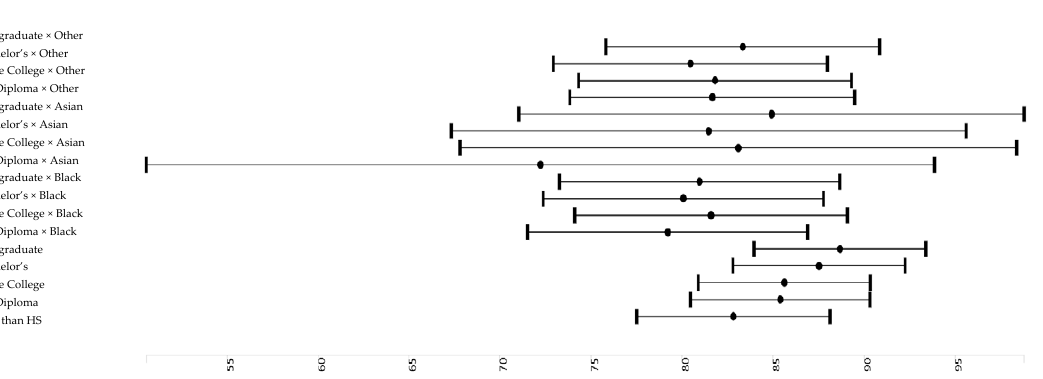
Figure 4. Parental education across groups.